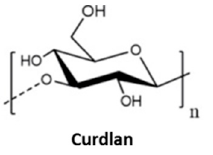
Figure 14. The structure of gellan gum. The hydrogels of deacetylated GG present improved mechanical properties upon decreasing the temperature of gellan gum solutions in the presence of Ca 2+ and Mg 2+ , being able to support the ECM deposition and cell proliferation [264]. A biomimetic in- jectable